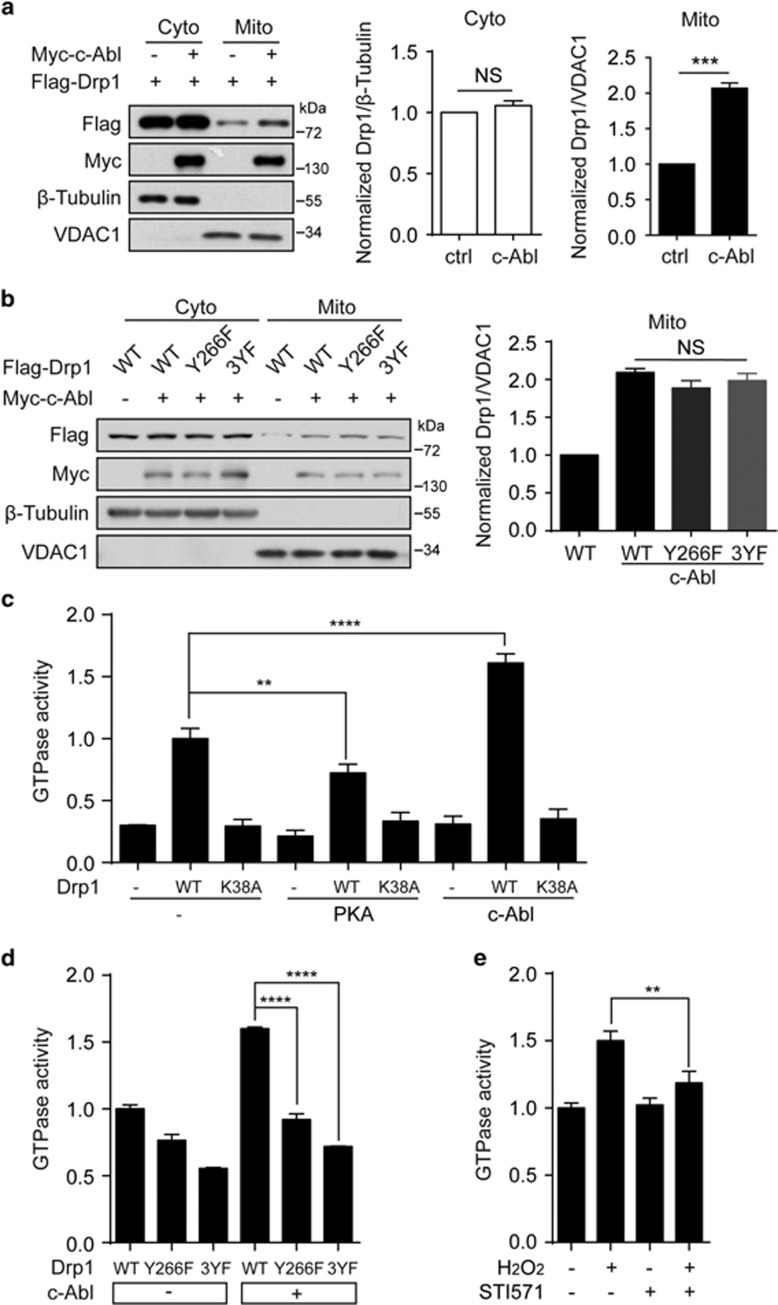
c-Abl-mediated Drp1 phosphorylation increases the GTPase activity of Drp1. (a) Left panel: Lysates of cytosolic and mitochondrial fractions of HEK 293T cells transfected with Flag-Drp1, with or without Myc-c-Abl, were immunoblotted with the indicated antibodies. Middle panel: The normalized levels of Drp1 in cytosolic fraction. (Student’s t-test, P=0.2, n=3). Right panel: The normalized levels of Drp1 in mitochondrial fraction. (Student’s t-test, ***P<0.001, n=3). (b) Left panel: Lysates of cytosolic and mitochondrial fraction of HEK 293T cells transfected with Flag-Drp1 WT and other mutants, with or without Myc-c-Abl, were immunoblotted with the indicated antibodies. Right panel: The normalized levels of Drp1 in mitochondrial fraction. (One-way ANOVA, P>0.05, n=3). (c) Immunoprecipitated Drp1 WT or K38A transfected with vector or c-Abl or PKA in HEK 293T were subjected to GTPase assay. Drp1 K38A and PKA group were used as negative and positive controls, respectively (one-way ANOVA, **P<0.01, ****P<0.0001, n=3). (d) Immunoprecipitated Drp1 WT or mutants transfected with or without c-Abl in HEK 293T were subjected to GTPase assay. (one-way ANOVA, ****P<0.0001, n=3). (e) SH-SY5Y cells were untreated or treated with 200 μM H2O2 for 4 h, with or without 5 μM STI571. Then immunoprecipitated Drp1 were subjected to GTPase assay. (one-way ANOVA, **P<0.01, n=3). NS, not significant